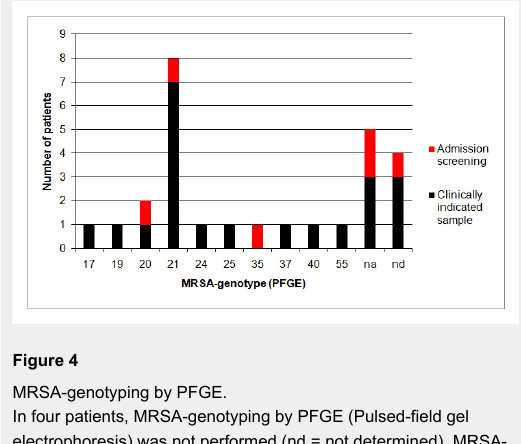
MRSA-genotyping by PFGE. In four patients, MRSA-genotyping by PFGE (Pulsed-field